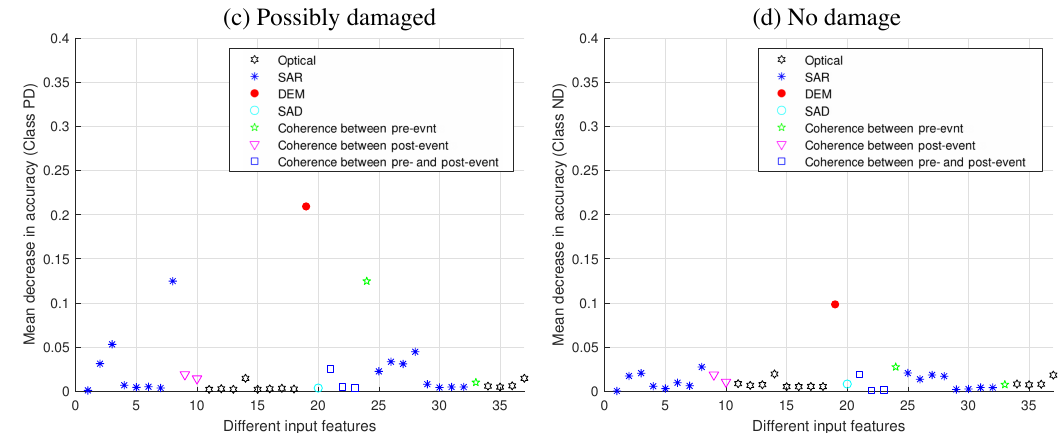
Figure 6. Feature importance of each damage type by using mean decrease in